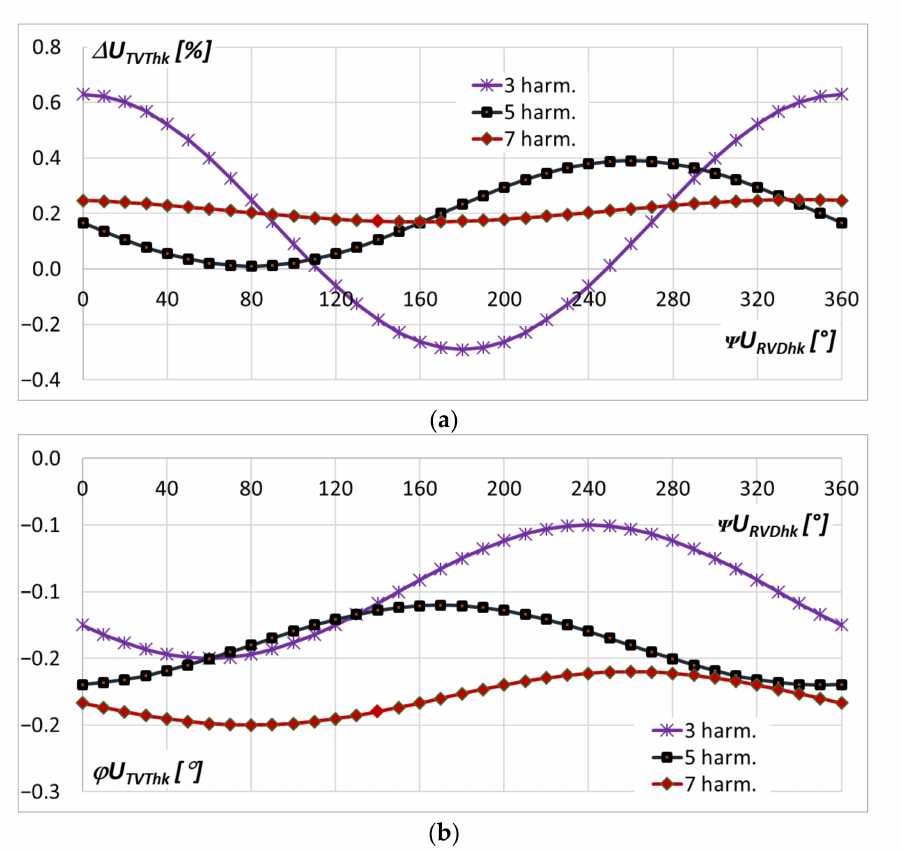
Figure 6. The changes of the values of voltage error ( a ) and phase displacement ( b ) with the phase angle of transformed higher